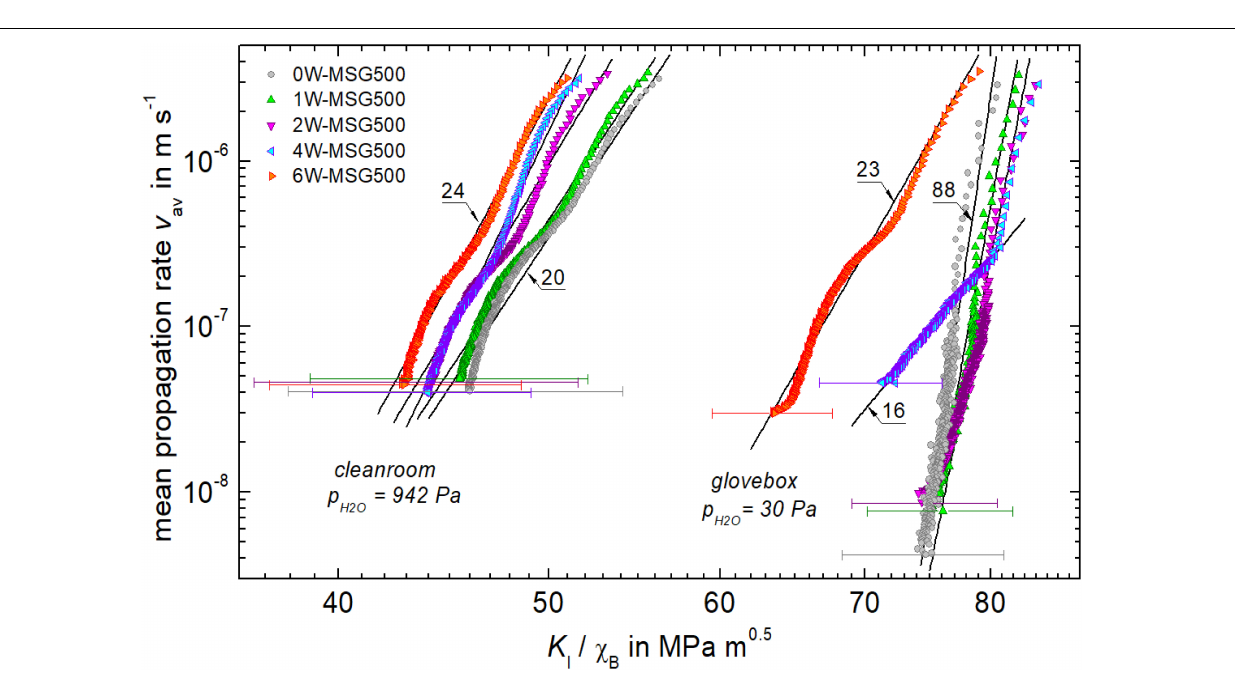
FIGURE 6 | Temporal evolution of the crack initiation probability as a function of the water speciation in low (A) and high (B) humidity.